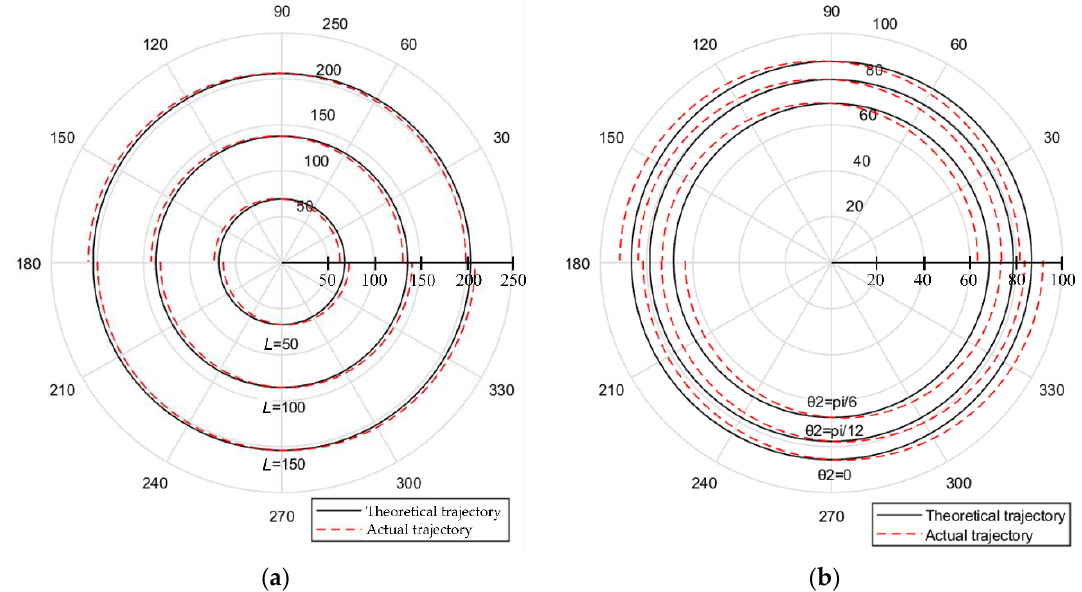
Figure 8. Simulation results of the influence of the opposite clearance on the circular motion trajectory of machine tool. ( a ) The result under different bar lengths. ( b ) The result under different pose angles.